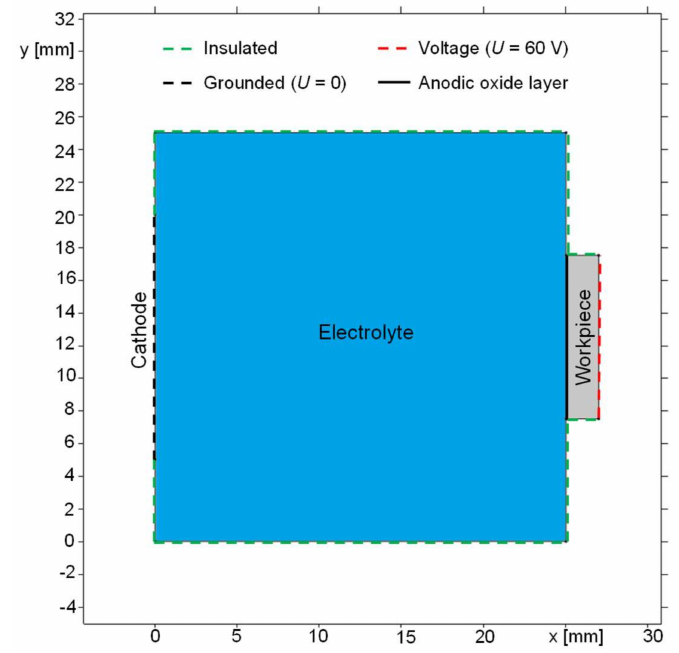
Figure 2. Geometry of immersion-based anodization for parametric simulation. The model consists of a workpiece (colored as the grey area) with an anodic oxide layer (bold black line) and connected to an anodic potential of 60 V. The cathode’s surface (black dashed line) with a potential of 0 V and the electric conductivity of AISI 4340 is arranged vertically in parallel to the workpiece surface with a horizontal distance of 25 mm. The cathode’s vertical dimension was set to 15 mm and the anode’s vertical dimension to 15 mm according to the experiment described in Section 2.3. The electrolyte (blue-colored area) realizes the electrical contact between the workpiece and the cathode. The material parameters were the same as in the model described in Section 2.3. The simulation time was set to 30 min in analogy to the